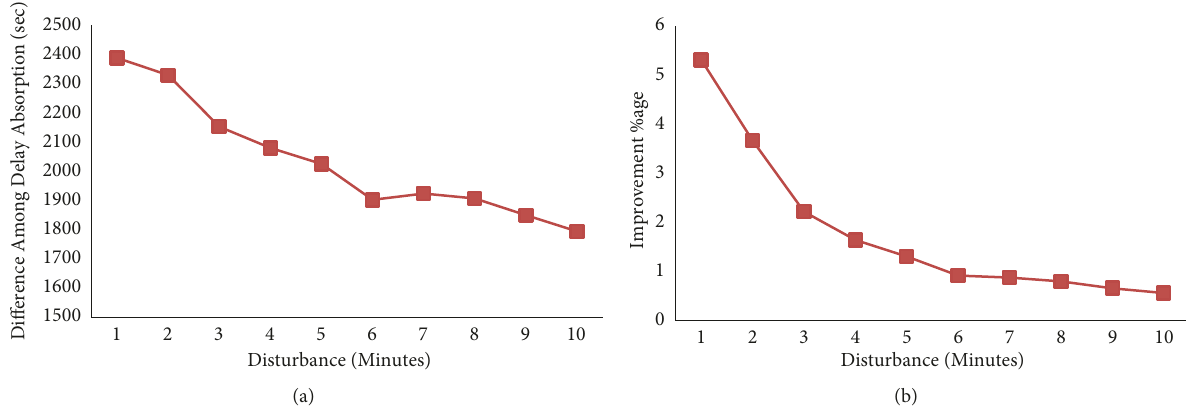
Figure 7: Delay absorption versus disturbance level: (a) delay observed vs increase in delay absorption by the modified timetable; (b) delay observed vs % improvement in delay absorption by the modified timetable.